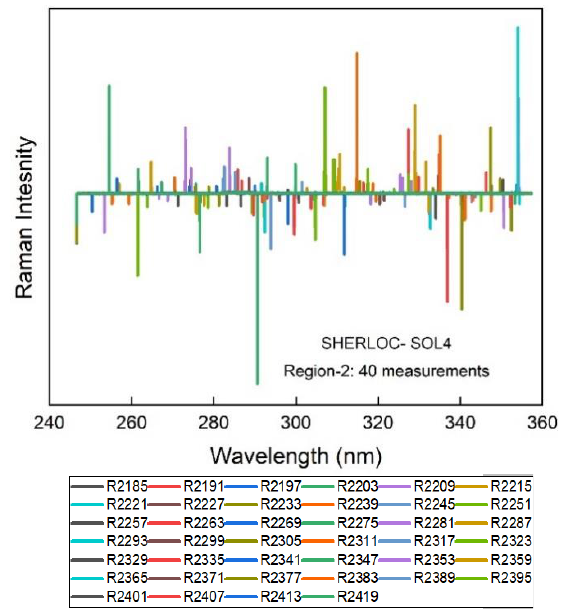
Figure 8. SHERLOC measurements for Sol 4 (Region-2)